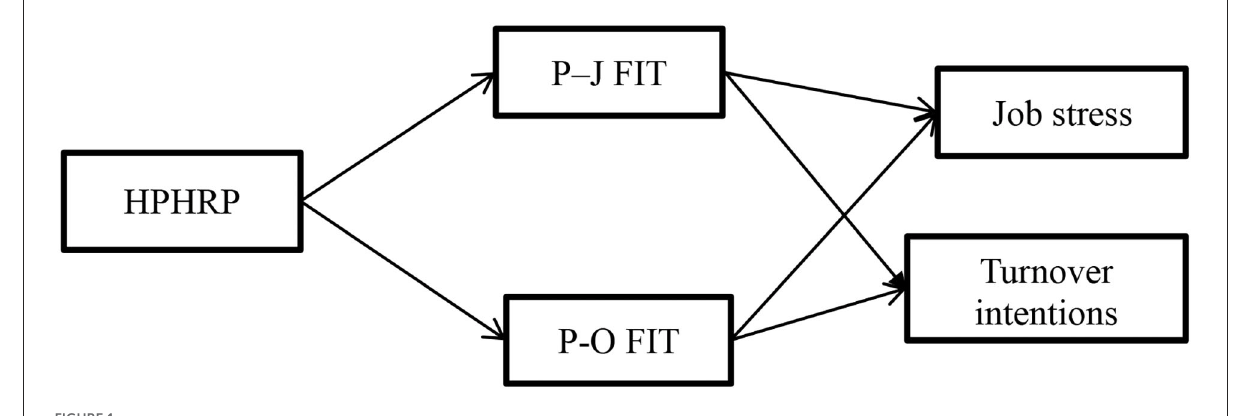
FIGURE1 Research